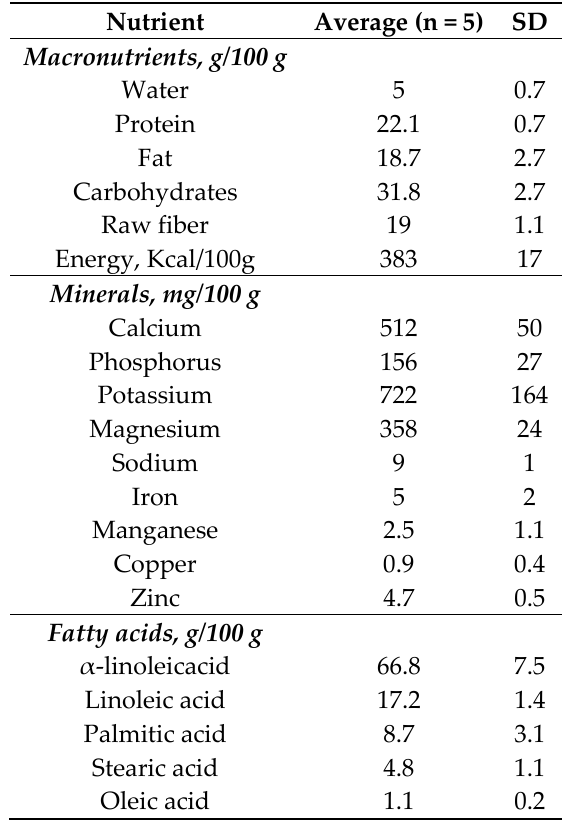
Table 1. Macronutrient, energy, mineral, and fatty acid content in S. hispanica